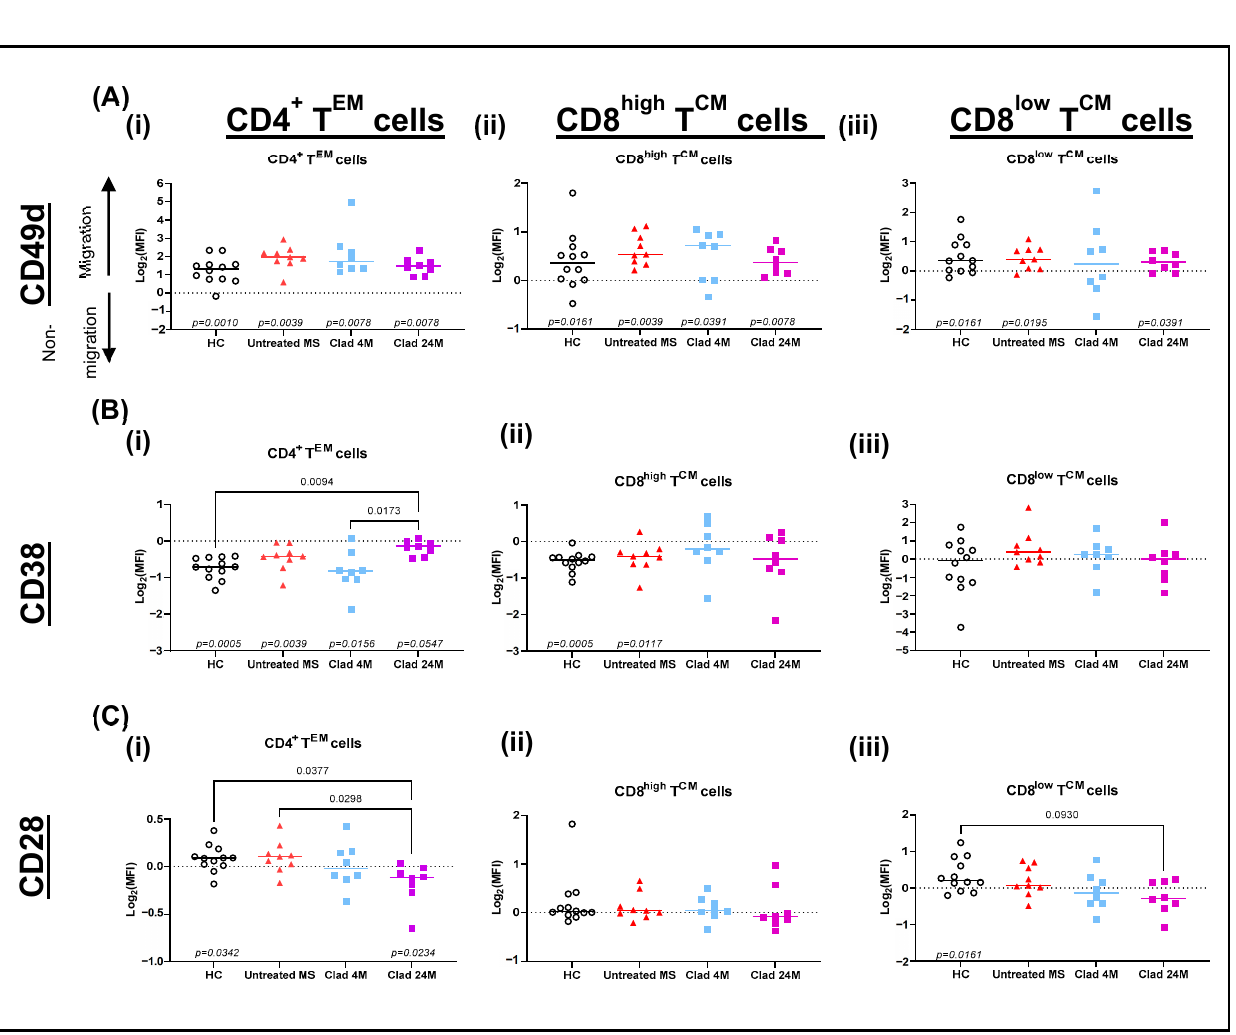
Figure 2. CD28 and CD38 expression are altered on migrated and non-migrated CD4 + T EM cells and CD8 + T CM cells. The logarithm of 2-fold change of marker expression on migrated to non-migrated cells was calculated. ( A ) CD49d ( B ) CD38 and ( C ) CD28 expression on ( i ) CD4 + T EM cells ( ii ) CD8 high T CM cells and ( iii ) CD8 low T CM cells. In-group analysis performed using a one sample Wilcoxon matched-pairs signed rank test with the Pratt method with p -values ≤ 0.1 displayed at the bottom of each graph. Between-group analysis performed using Kruskal–Wallis with Dunn’s multiple comparisons test. Median shown. NM; non-migrated, M; migrated; T CM , central memory T cells; T EM , effector memory T cells; HC healthy controls; MS, multiple sclerosis; Clad, cladribine; 4M, 4 months post-Clad; 24M, 24 months post-Clad.